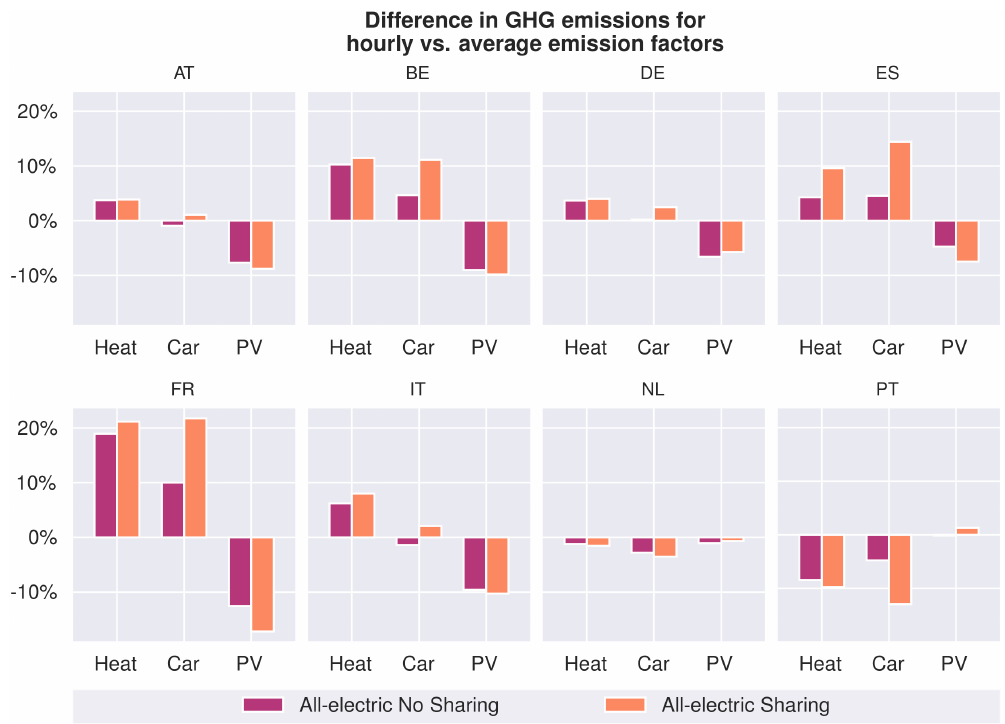
Figure 10. Difference between GHG emissions calculated using hourly emission factors vs. average emissions factors for heat supply, car usage and PV electricity. Positive bars indicate that with HEFs, calculated emissions are higher.